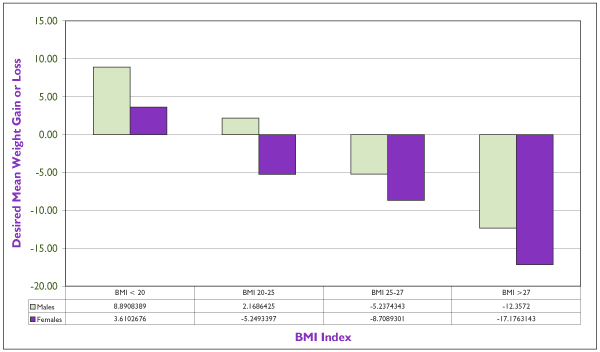
Desired Mean Weight Gain or Loss by Body Mass Index Category and Sex Source: Statistics Canada, National Population Health Survey 1996–1997